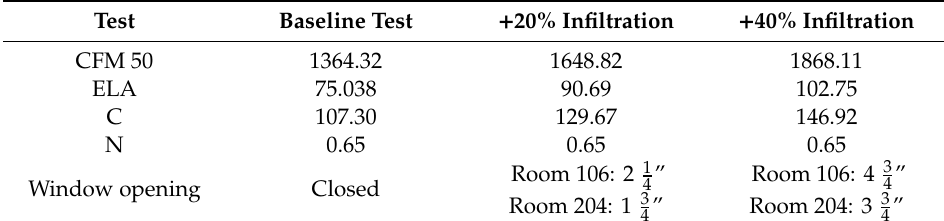
Table 9. Blower door test results for each